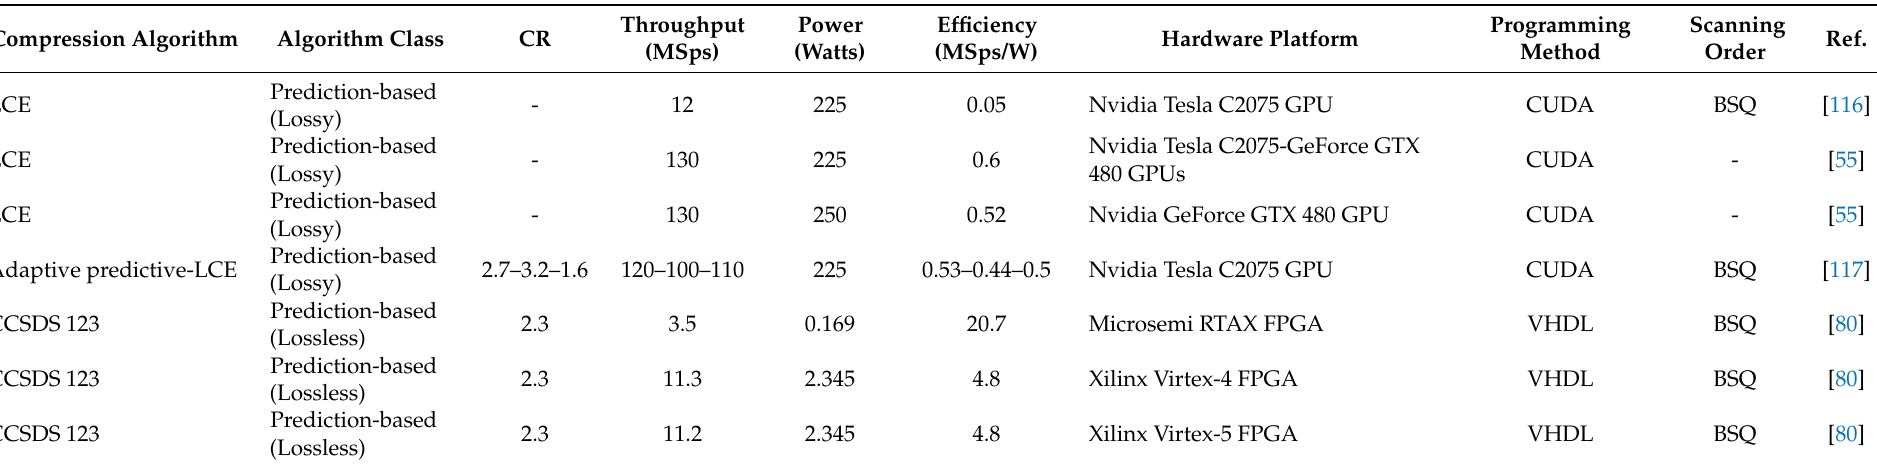
Table 14. Comparison of the proposed compression system validated using the AVIRIS Indian Pines image.